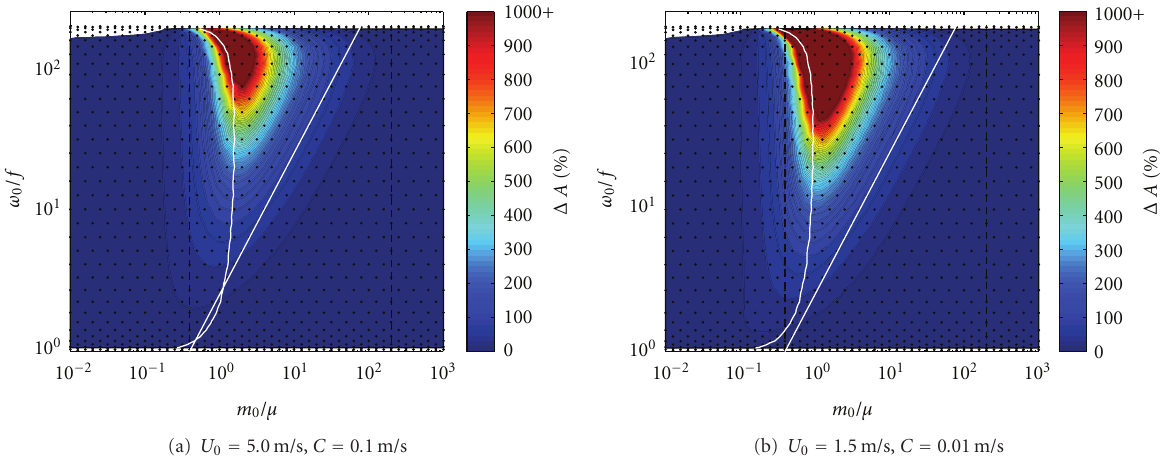
Figure 3: Contours of maximum change in wave action density for two scenarios with di ff erent background velocities and inertia phase speeds. The white line to the left shows the critical level boundary for a stationary background, and the white line to the right shows the value of the inertia wave phase